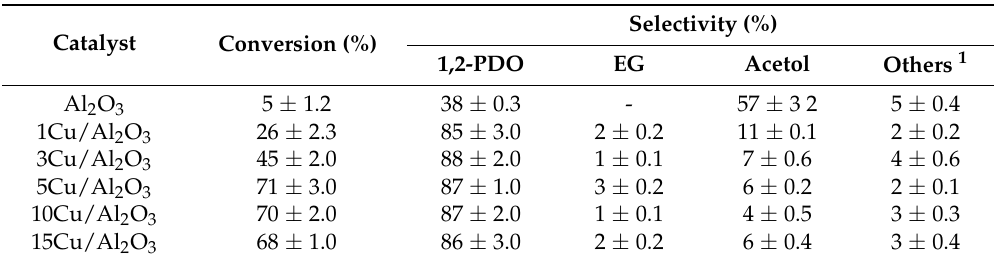
Table 2. Influence of Cu loading on activity of Cu/Al 2 O 3 catalysts for glycerol hydrogenolysis